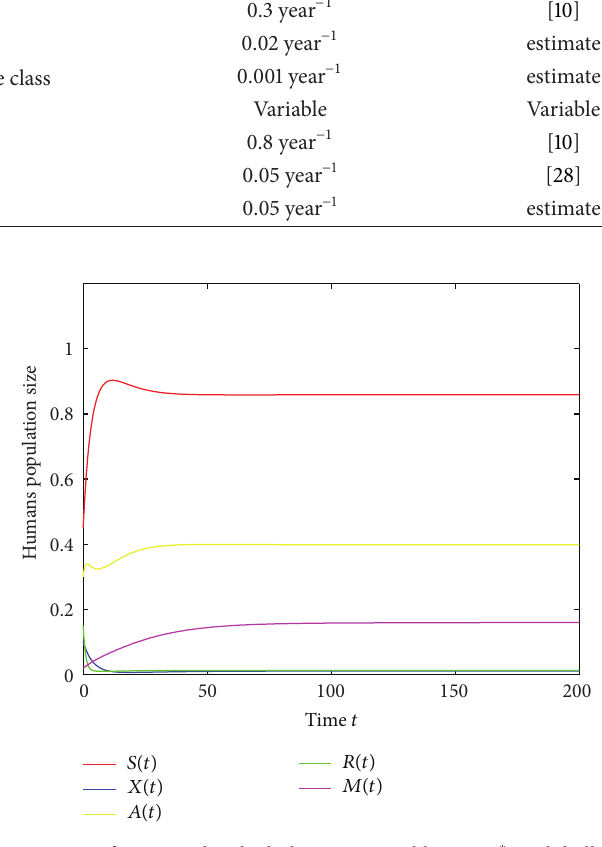
Figure 4: If 𝑅 0 > 1 , the alcohol present equilibrium 𝐸 ∗ is globally asymptotically stable.